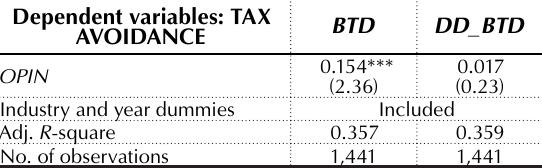
Table 6. The effect of foreign independent director